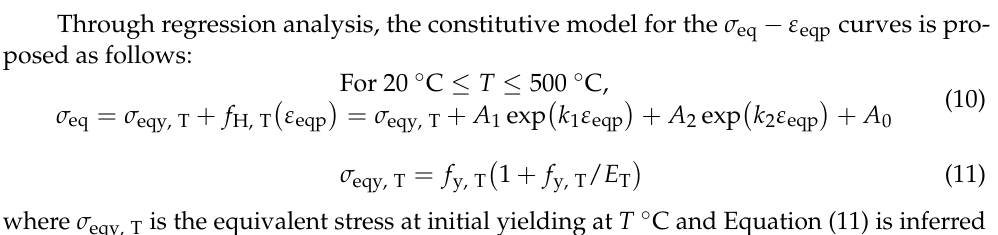
Note: the ratio in the first column means the ratio between predicted and test results; subscripts 1 and 2 represent Huang’s and the present formulations, respectively.